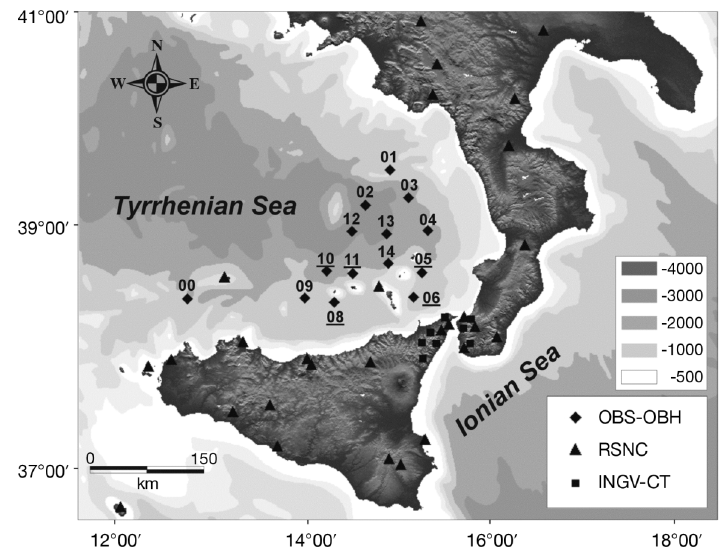
Fig. 1. Location of OBS-OBH (diamonds) and land-based seismic stations (triangles and squares) used in the present work. Each ocean bottom station was equipped with an OBH (1 channel), those equipped with an addi- tional 3-component seismic sensor (OBS) are represented by underlined numbers. Station no. 07 is not reported on the map as it was not recovered. The label 00 reports the position of the GEOSTAR multi-parametric obser- vatory, hosting an